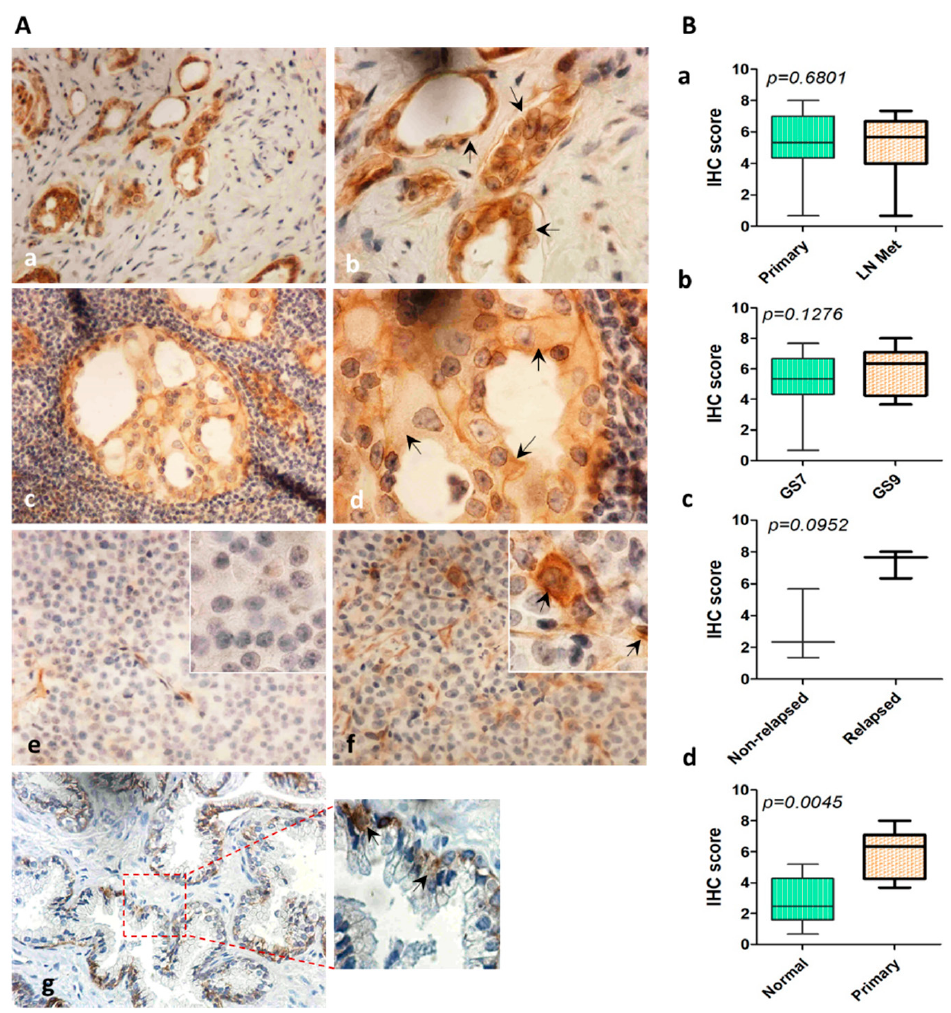
Figure 6. Expression of ITGA2 in PCa tumors with lymph node metastasis. Tissue cores were stained with anti-ITGA2 antibody. ( A ) Immunostaining of PCa tissue cores of primary ( a , b ) and lymph node metastasis tumors ( c , d ). Expression of ITGA2 was evaluated in non-relapsed ( e ), relapsed ( f ), and normal ( g ) tissue specimens. ( B ) Immunohistochemical score of ITGA2 in primary versus tumors with lymph node metastasis ( a ). High Gleason score (GS9) versus low Gleason score (GS7) ( b ). Relapsed versus non-relapsed tumors ( c ), and normal versus primary tumors ( d ). Magnification was 400 × ( a , c , e – g ) and 1000 × ( b , d inserts).